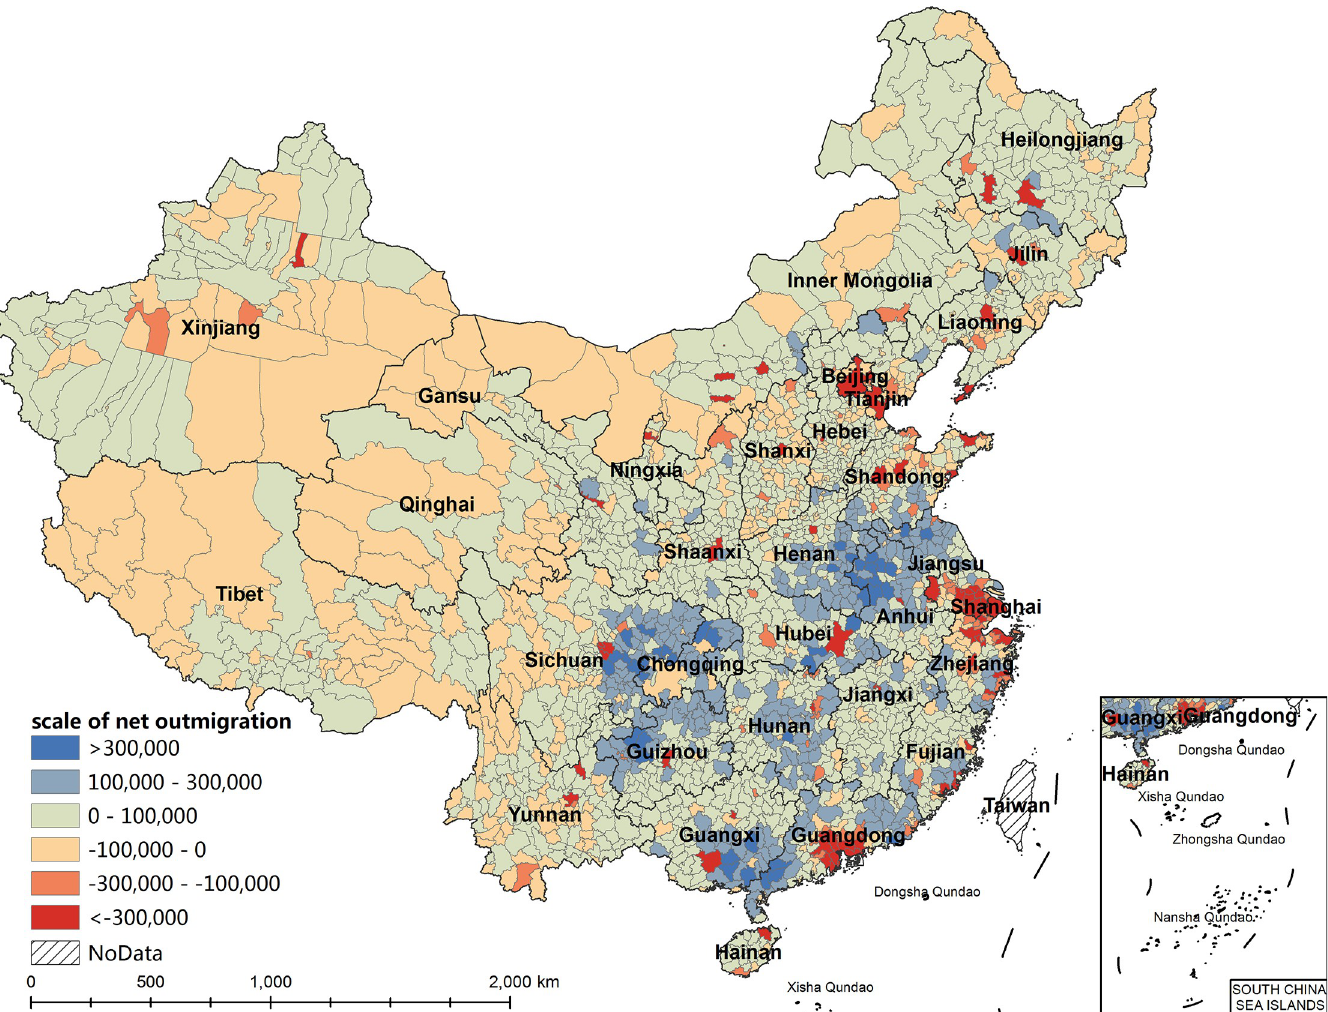
Fig 1. The spatial distribution of the scale of net outmigration at the county level in China,